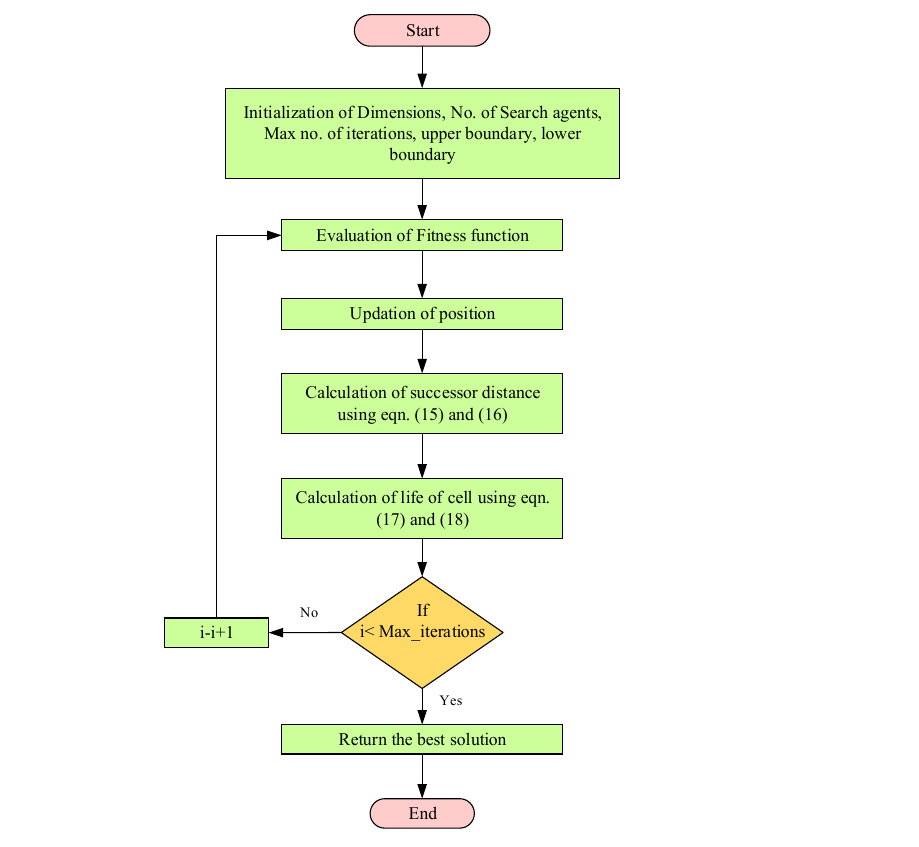
Figure 3. Flow chart for WFS2ACSO algorithm.